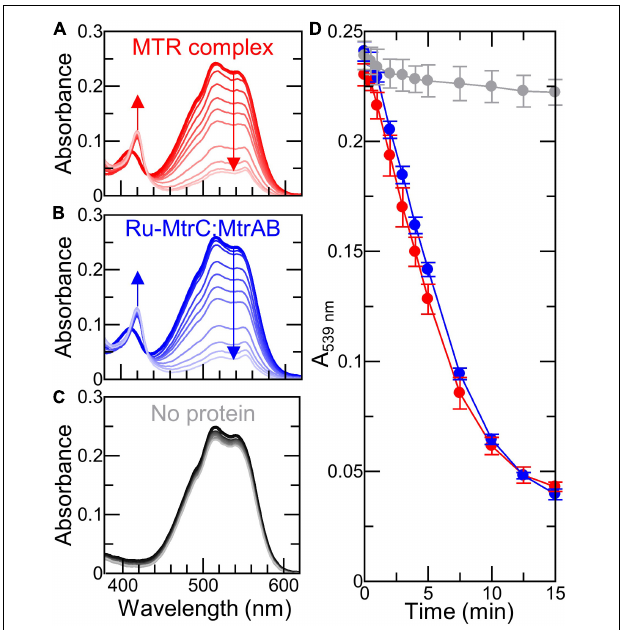
FIGURE 6 | Dithionite-driven electron transfer across (proteo-)liposome bilayers (A–C) Spectra of 6 nM (proteo-) liposomes containing RR120 with indicated proteins before (thick line) and over 30 min following addition of 0.1 mM dithionite (thin lines); arrows indicate bleaching of RR120. Samples in 50 mM Tris:HCl and 10 mM KCl, pH 8.5. Scattering due to liposomes has been subtracted; see text for details. (D) Time course for bleaching of encapsulated RR120 from (A–C) with data points connected for clarity. Data are the average of n = 3 datasets and error bars show standard deviation.